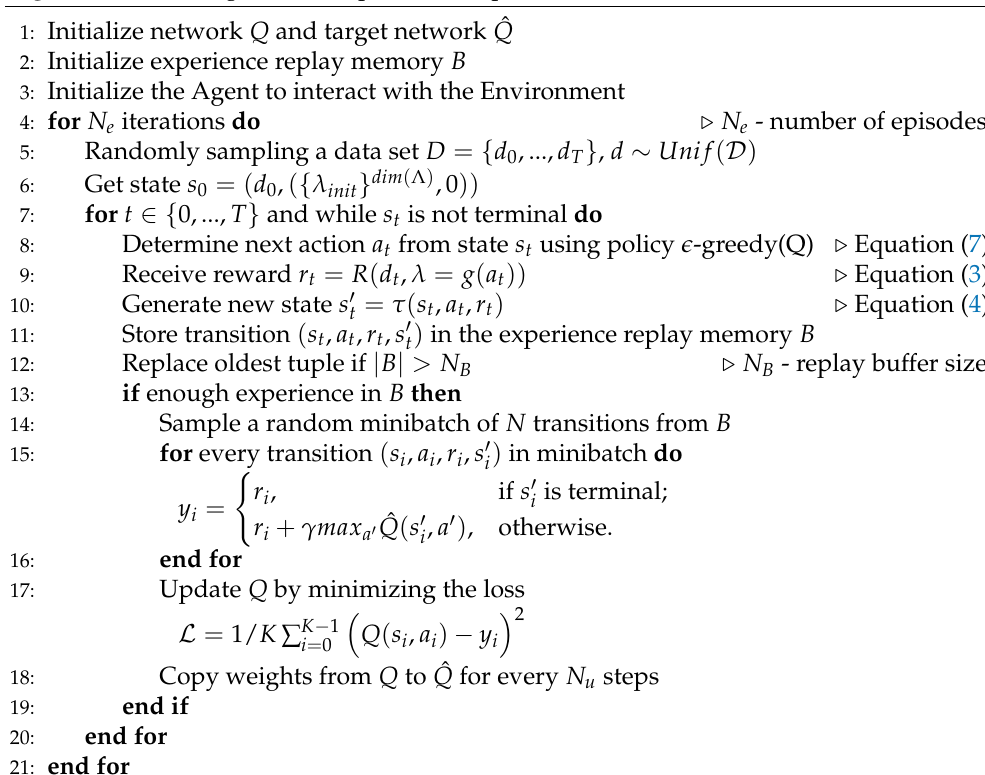
Algorithm 1 DRL algorithm for parameter